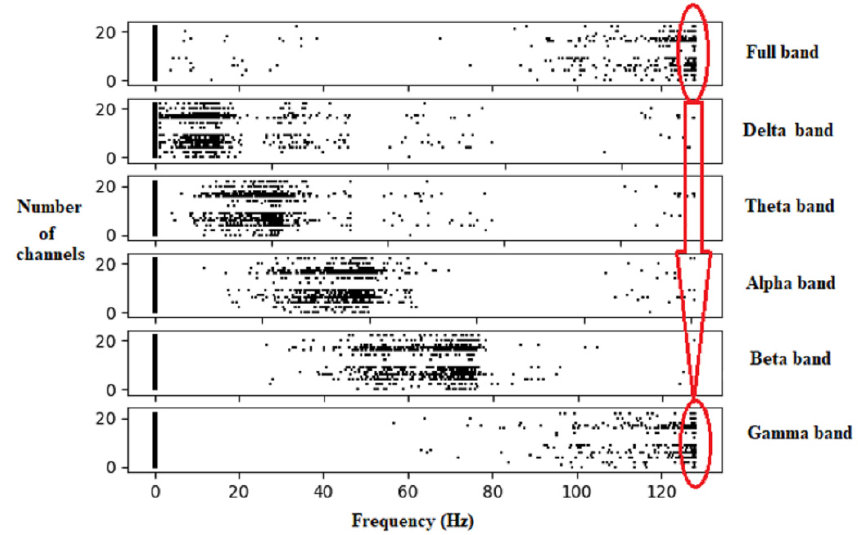
Figure 4. Extraction of high frequency by employing MCSV